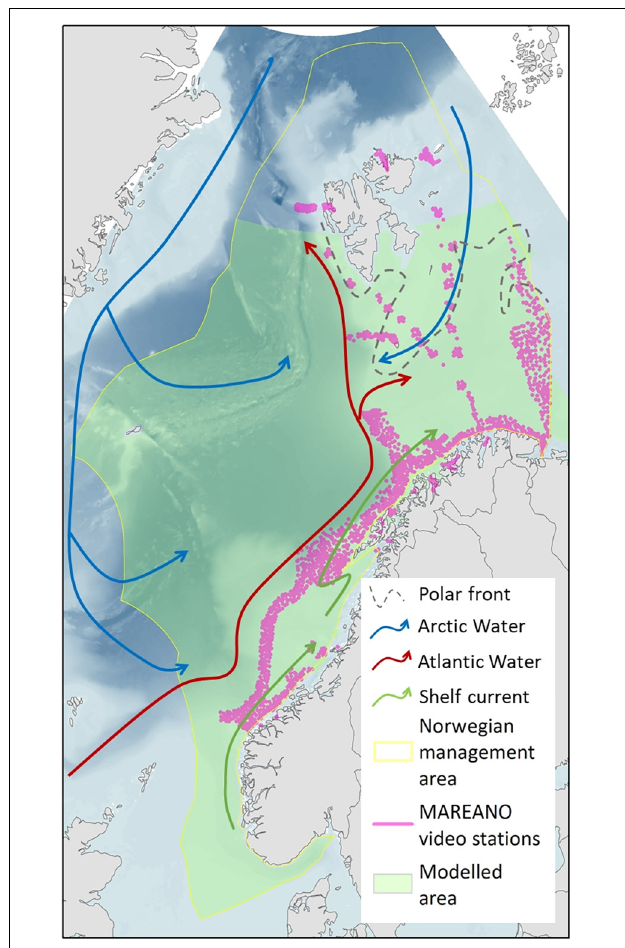
FIGURE 1 | Map of the study area. The study area map includes approximate directions of dominant currents and the polar front which forms a putative biogeographic boundary, together with the modelled area (restricted by mapped environmental layer coverage), and the locations of MAREANO video transects that were used as the basis of this